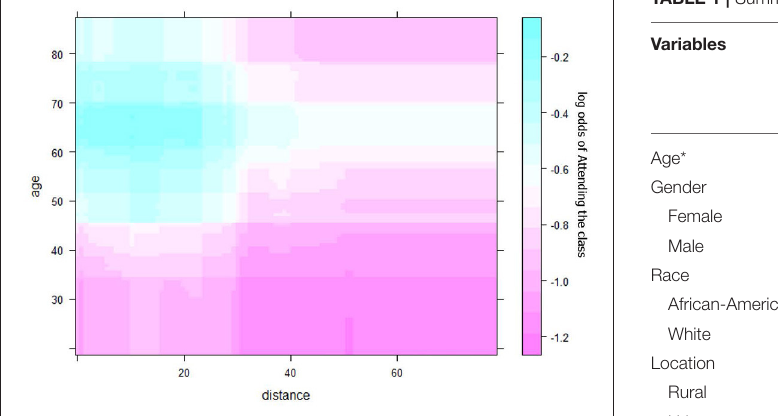
TABLE 1 | Summary statistics classified by smoking cessation class attendance.